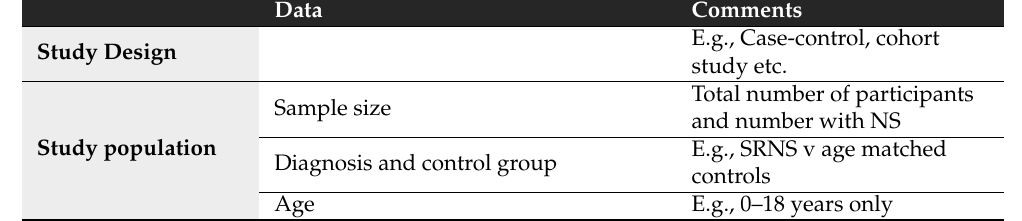
Table 1. Systematic review data extraction form.